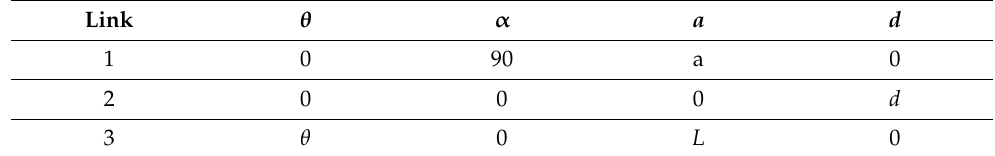
Table 3. First finger link table on right front wheel.